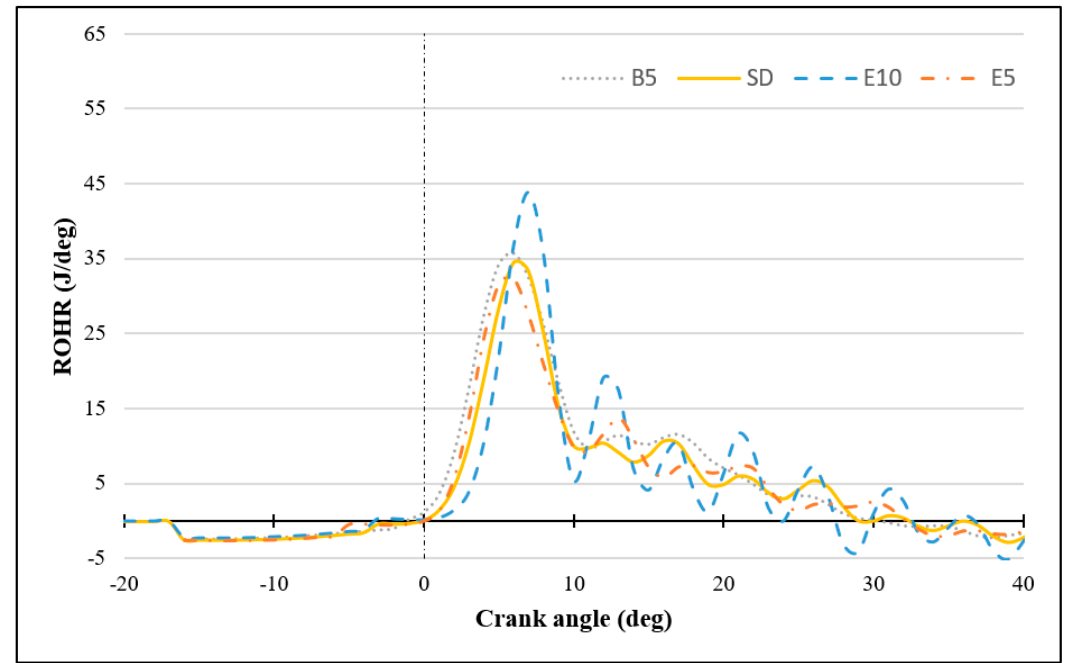
Figure 15. Comparison of the ROHR at 3 kW for various fuels.